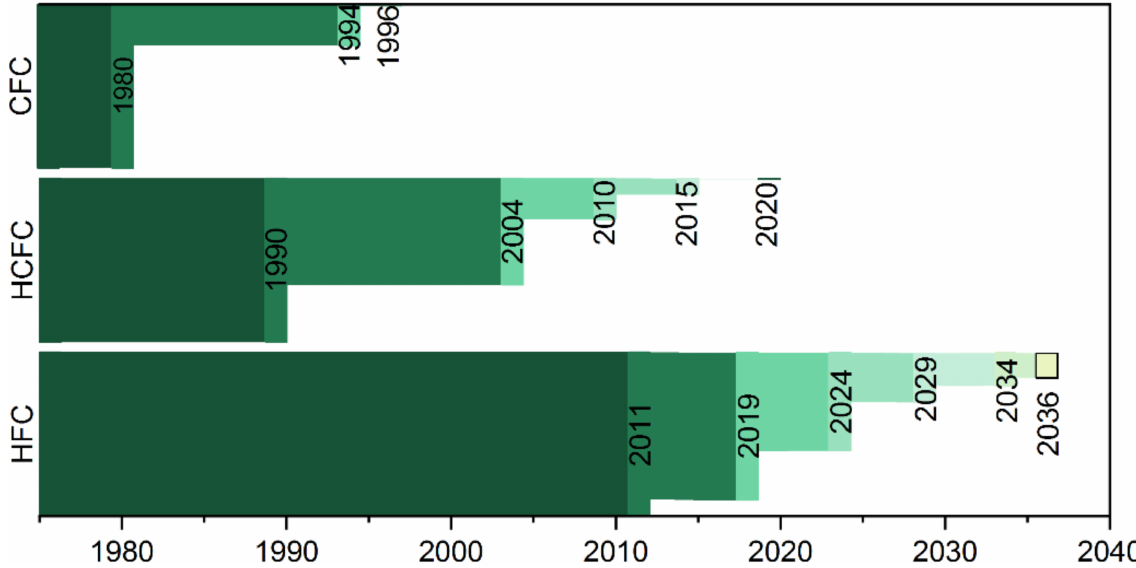
Figure 2. Sankey diagram representing blowing agents phase out for non-article 5 countries (indus- trialized) agreed in the Montreal Protocol and Kigali